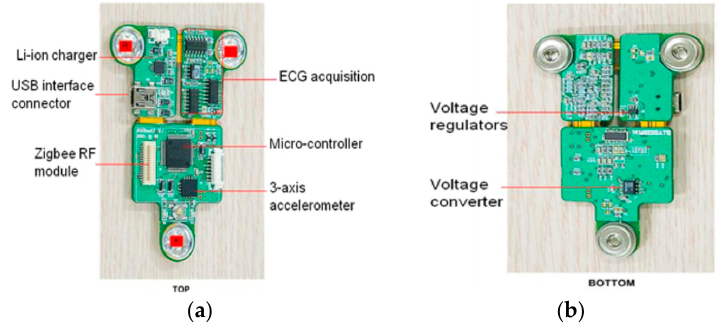
Figure 2. ( a ) Top and ( b ) bottom views of the sensor node.